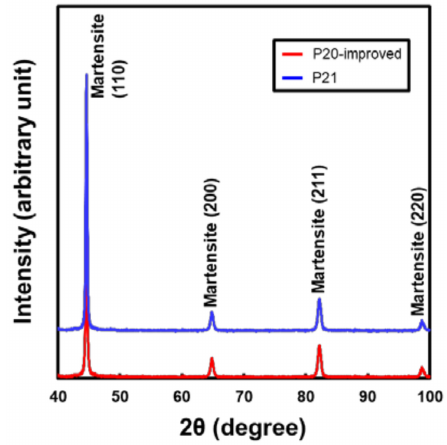
Figure 3. Patterns of XRD obtained from P20-improved and P21 steels